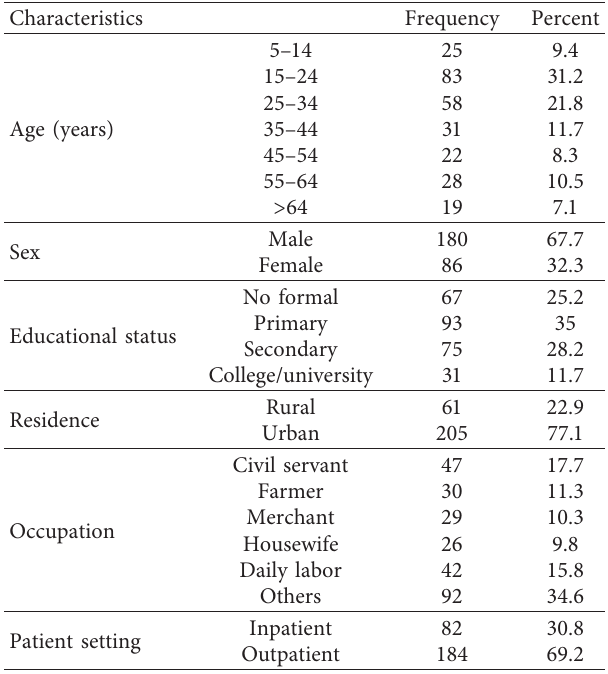
Table 1: Sociodemographic characteristics of patients with wound infections at Dessie Referral Hospital, Northeast Ethiopia.